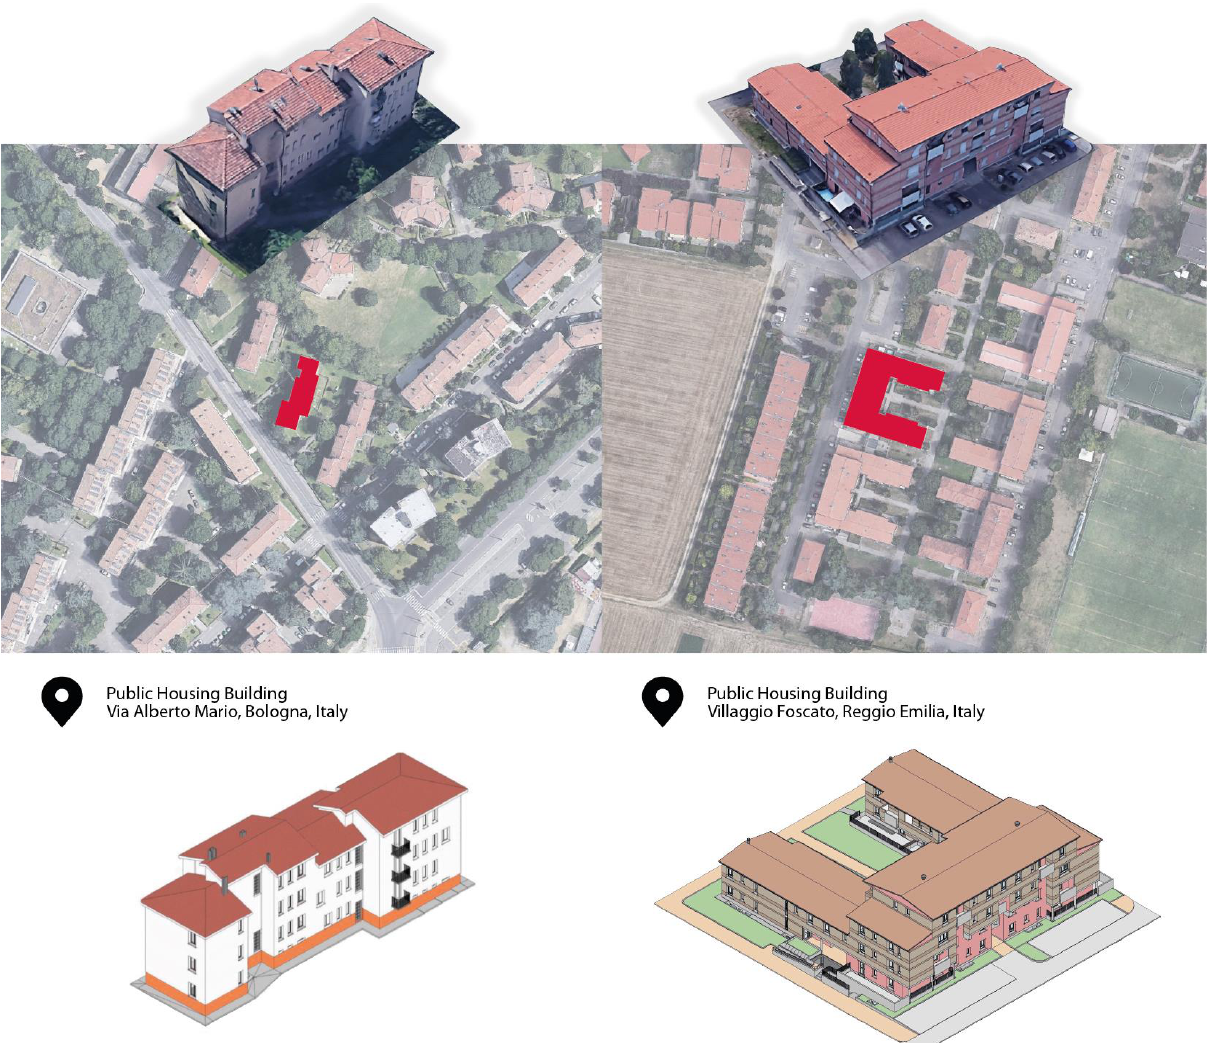
Figure 1. Some case studies of social housing implemented in the InSPiRE